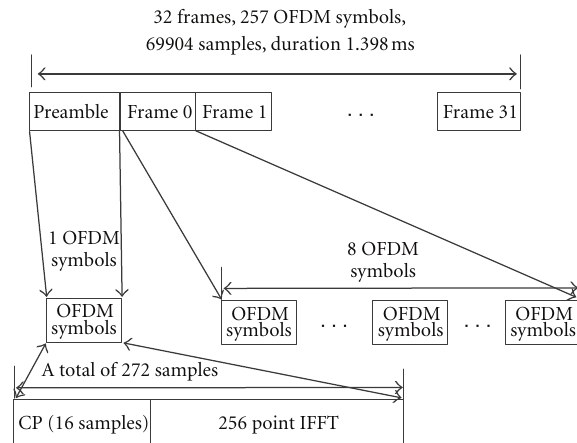
array is used. The frequency and transmission distance are 15 GHz and 2km,